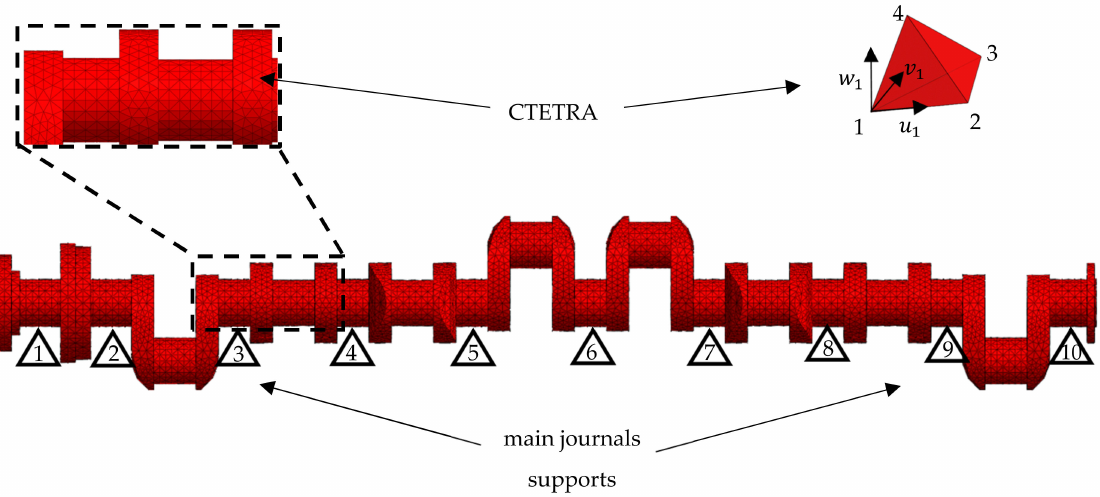
Figure 2. Finite element model of the analyzed crankshaft with the adopted numbering of the supported main